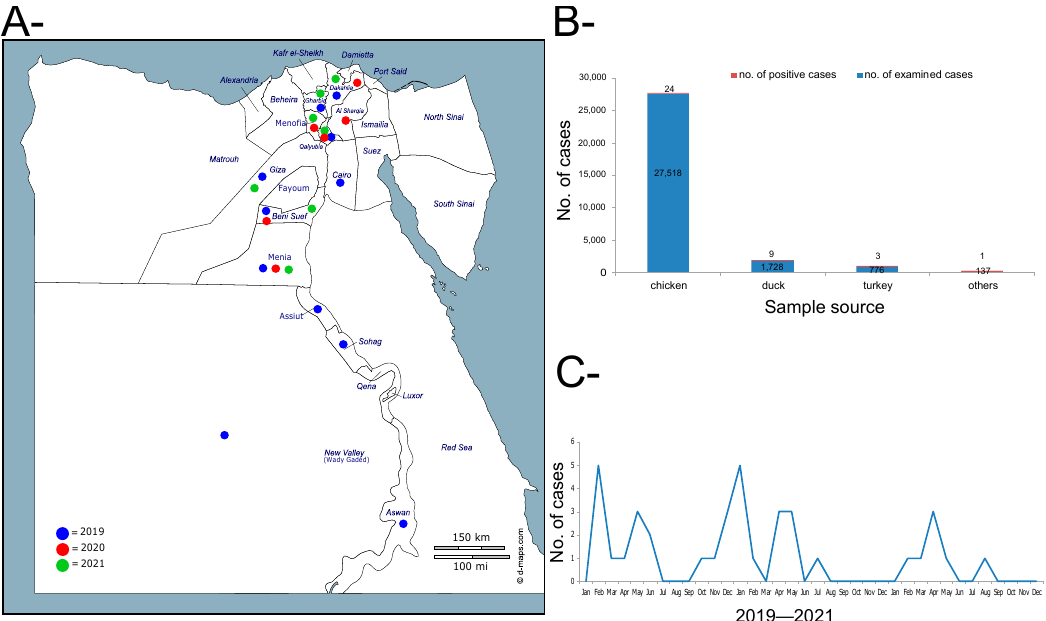
Figure 1. Surveillance and epidemiological features of H5N8 in Egypt commercial farms, 2019–2021. ( A ) Geographical distribution of HPAI H5N8 viruses in Egypt during 2019–2021. ( B ) Number of samples collected from each species indicating the total tested and the total detected as positive for the H5N8 virus. “Others” indicates other sources rather than chicken, duck, and turkey (e.g. environmental samples). ( C ) Distribution of positive H5N8 per month over 2019–2022.